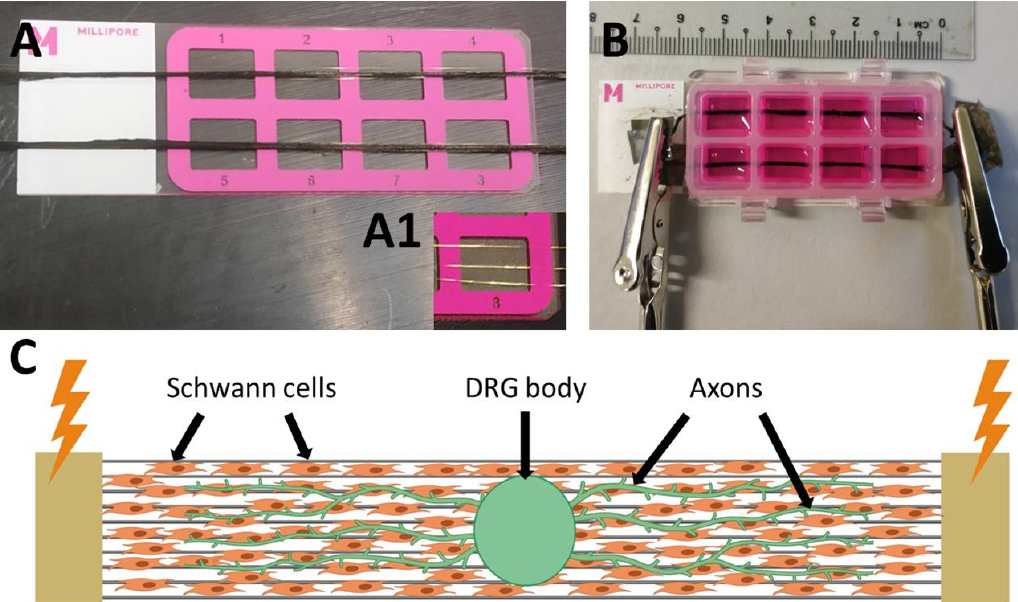
Figure 4. Images of the bioreactor for electrical stimulation. ( A ) Image of the PLA-PPy-Au microfiber lane placed on the top of the slide. The gold microfibers are placed below the PLA-PPy microfibers, as can be appreciated in insert A1. ( B ) Image of the fully assembled device, showing the electrodes placed at the extremes of the microfibers. Two PLA-PPy-Au substrates are placed between the slide and the wells, one per row, and connected in parallel to the electrodes avoiding contact with the culture medium. ( C ) Scheme showing the microfiber lane corresponding to one of the wells with the coverage of pre-seeded Schwann cells, the DRG body containing the somas of the neurons and the axons sprouting from the DRG body in an aligned way following the direction of the microfibers.